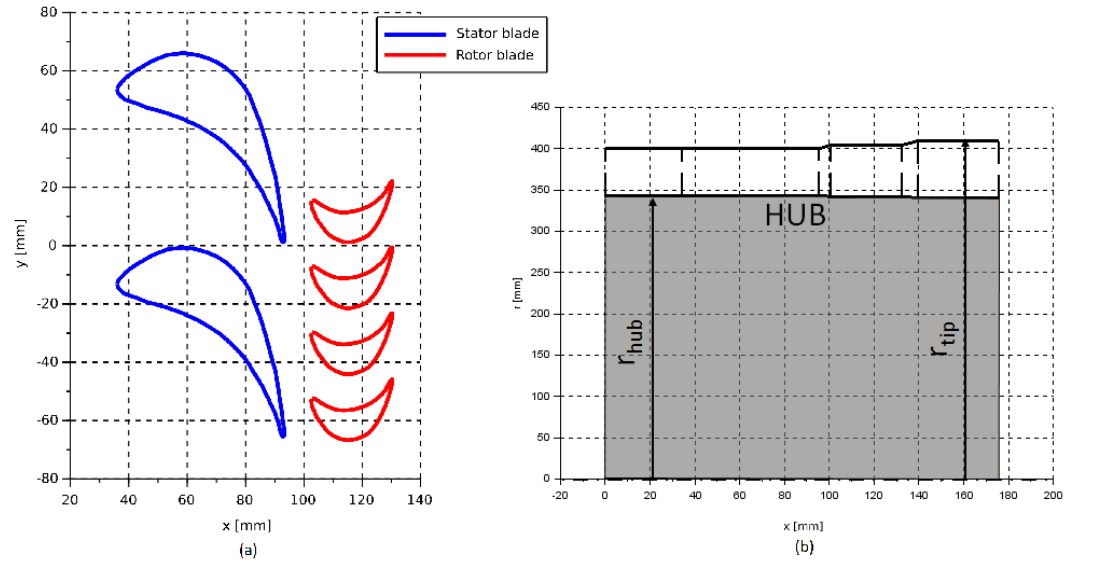
Figure 3. Blade geometry of the test case TK9-TW3 turbine: ( a ) blade-to-blade plane; ( b ) throughflow